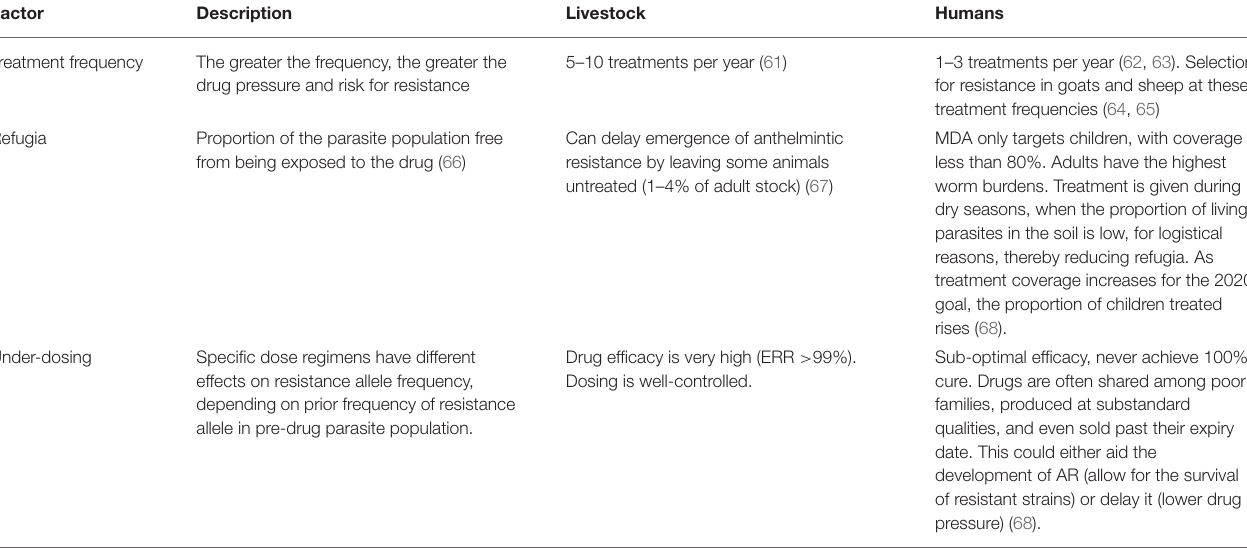
TABLE 3 | Factors influencing the emergence of anthelmintic resistance in